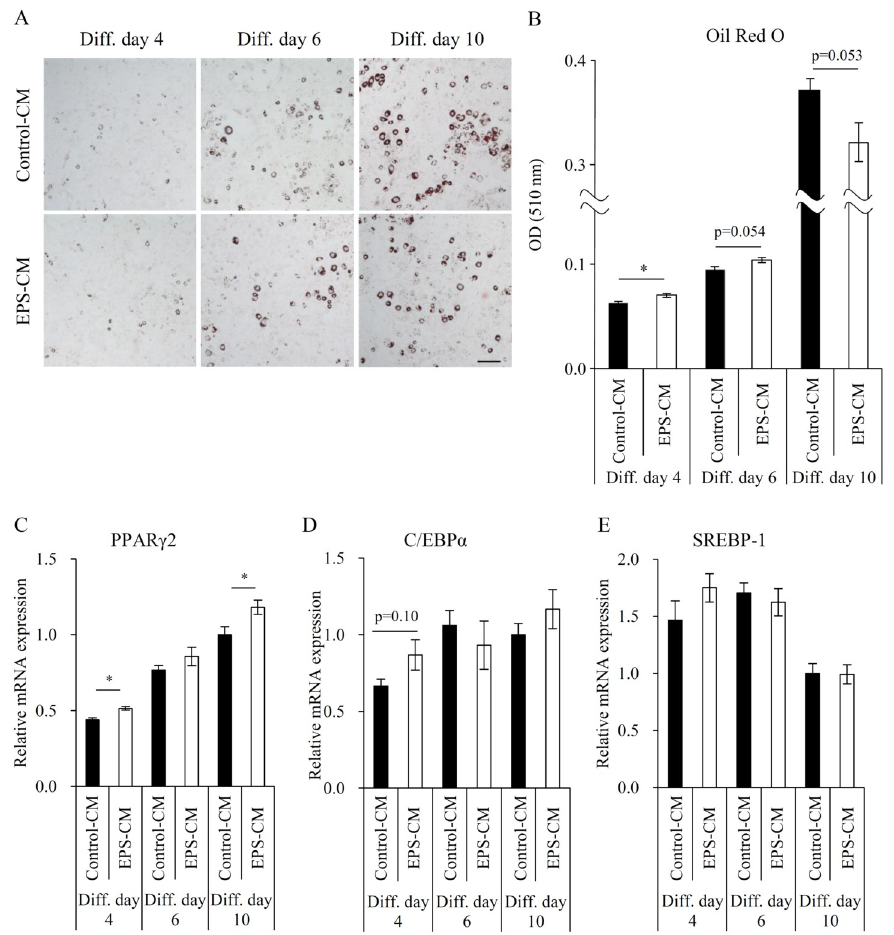
Fig 2. Effects of myotube EPS-CM treatment on differentiation and lipid accumulation of 3T3-L1 adipocytes. Differentiating 3T3-L1 adipocytes were continuously treated with 50% myotube EPS-CM. (A) Representative images of adipocytes stained with Oil Red O on days 4, 6, and 10 post-differentiation, (B) followed by the measuring of total lipid amount. (C-E) The expression levels of PPAR γ 2, C/EBP α , and SREBP-1 were evaluated via qRT-PCR on days 4, 6, and 10. Data are expressed as mean ± SEM (n = 3–4). � ; p < 0.05. N.S., not significant. Scale bar, 200 μ m. orthovanadate, 1 mM ethylenediaminetetraacetic acid (pH 8.0), 1% Nonidet P-40, 150 mM sodium chloride, 10 mM sodium fluoride, 10 mg/L leupeptin, 3 mM benzamidine, 5 μ g/mL aprotinin, and 1 mM phenylmethylsulfonyl fluoride, as previously reported [14]. 3T3-L1 adi- pocyte extracts were prepared in lysis buffer containing 50 mM Tris-HCl (pH 7.6), 150 mM NaCl, 1% Nonidet P40, 0.5% Sodium Deoxy Cholate, Protease Inhibitor Cocktail, and 0.1% SDS (RIPA Buffer; Nakarai tesque, Kyoto, Japan). Protein concentrations of all samples were measured via a Bradford protein assay (Bio-Rad, Hercules, CA). The lysates or media of C2C12 myotubes and 3T3-L1 adipocytes were separated on an SDS-polyacrylamide gel and transferred onto polyvinylidene fluoride membranes. The membranes were then blocked with Tris-buffered saline, which comprised 0.1% Tween 20 and 5% non-fat dry milk (for adiponec- tin and β -actin), 5% bovine serum albumin (for perilipin-1), 2.5% non-fat dry milk and bovine serum albumin (for AMPK and phospho-AMPK), and PVDF blocking reagent (TOYOBO, Osaka, Japan; for IL-6 and IL-15). Subsequently, the membranes were incubated overnight with appropriate primary antibodies as follows: anti-adiponectin (A6354, Sigma),